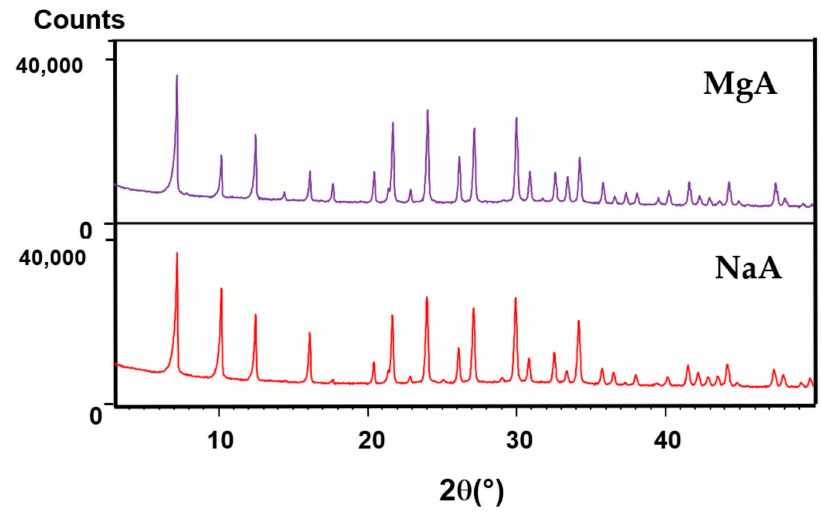
Figure 2. XRD patterns of the raw LTA-type zeolite and its associated MgA form.